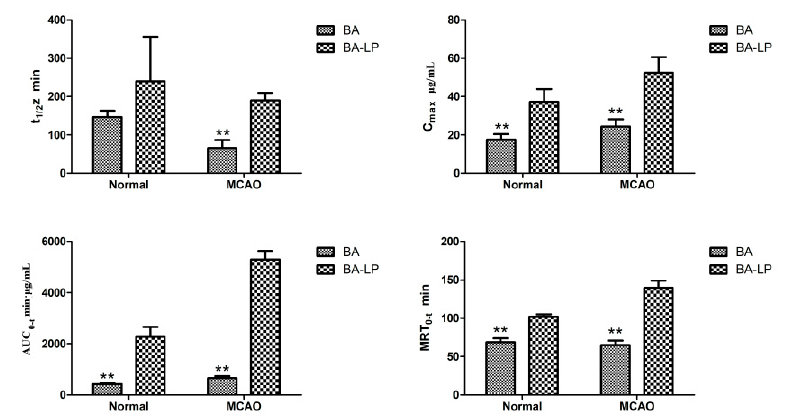
Figure 6. The statistical significances of t 1/2 z, C max , AUC 0–t and MRT 0–t between administration of BA and BA-LP ( n = 5, * * P < 0.01).